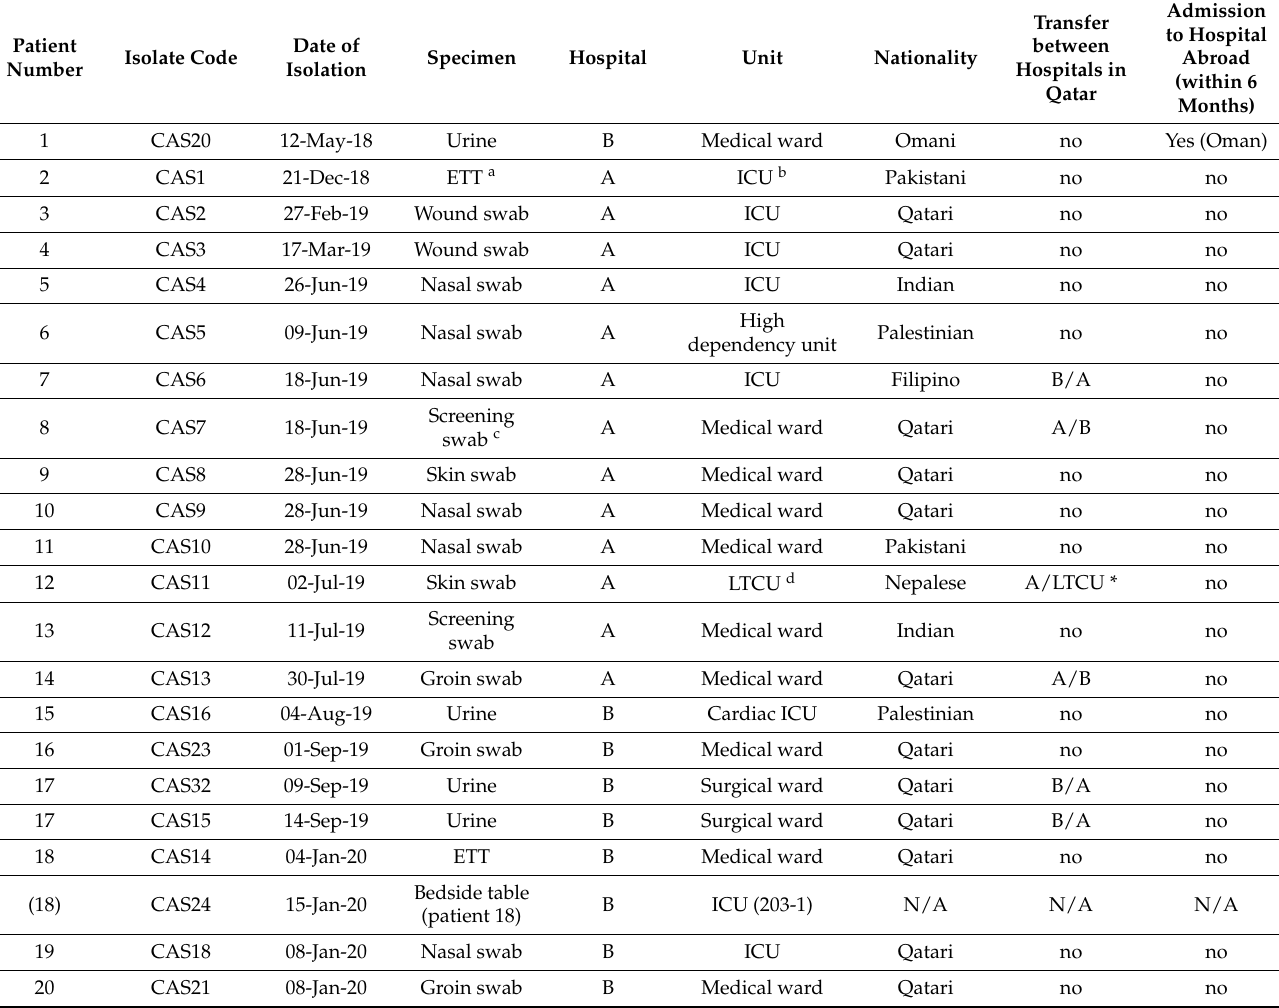
Table 1. Clinical epidemiology of the Candida auris